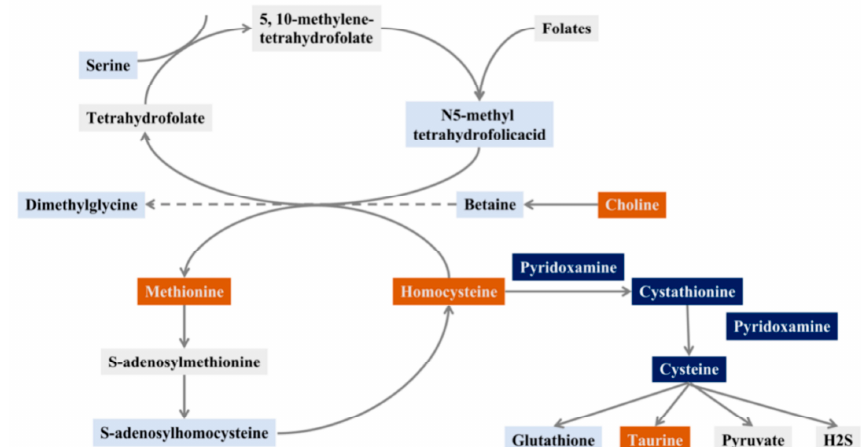
Figure 1. Schematic diagram of the Hcy pathway (orange: screening out metabolites closely related to diabetes, dark blue: screening potential metabolites related to diabetes, light blue: this study de- tected, but no metabolite related to DM was found, grey: unscreened metabolites in the sample).